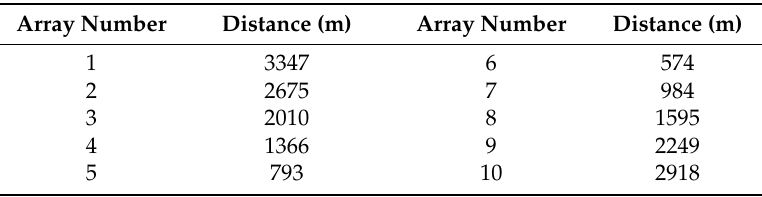
Table A2. Straight-line distance between S/S and first wind